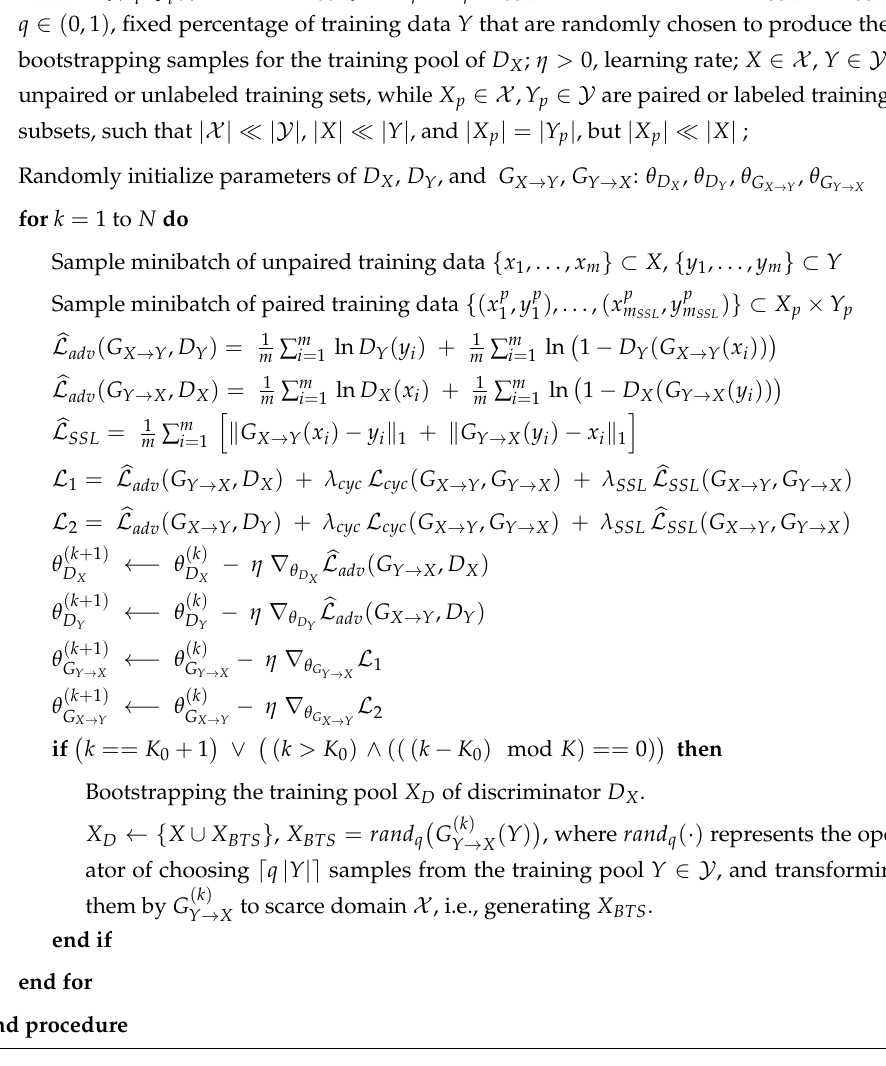
Algorithm 2 BTS-SSL CycleGAN